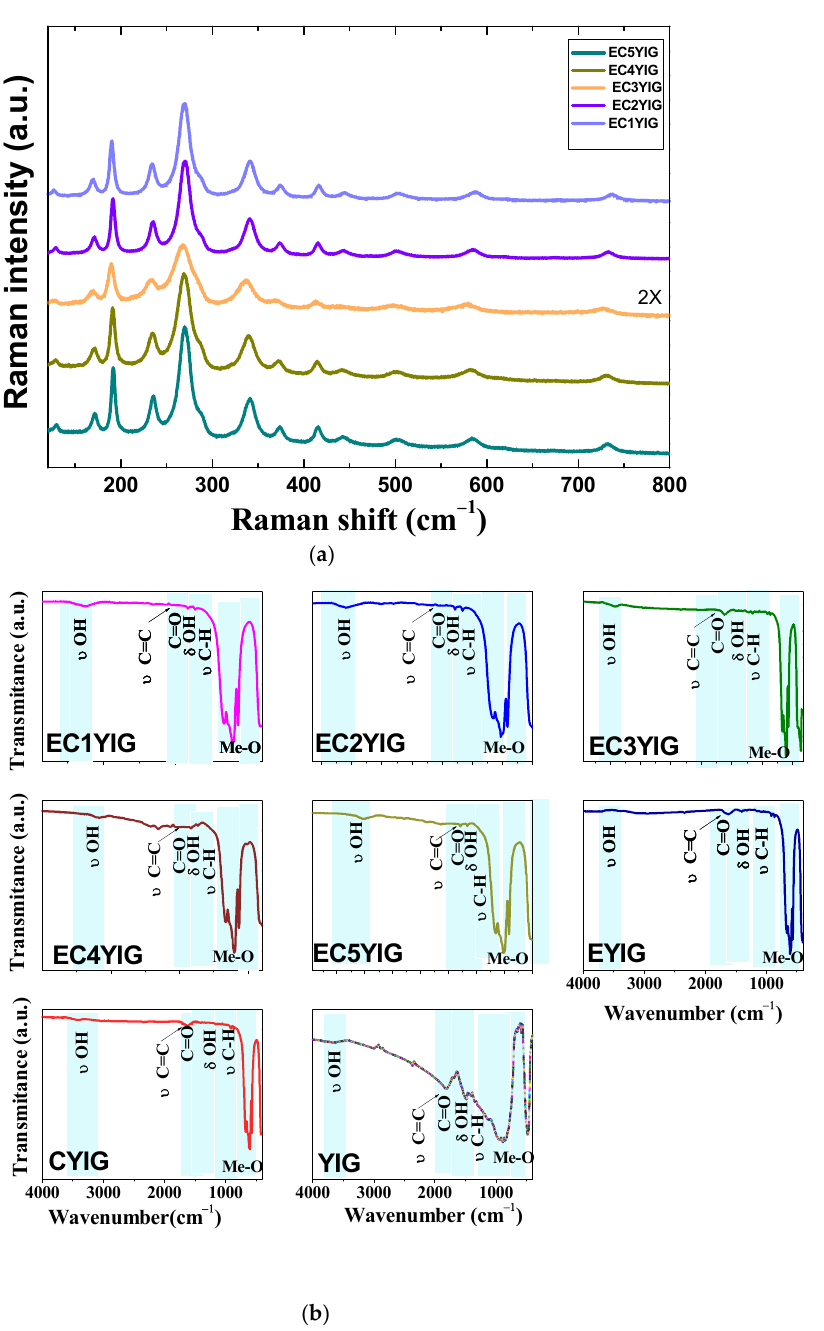
Figure 4. Structural features of spent yttrium iron garnet ferrites by ( a ) Raman and ( b ) FTIR measurements. For Raman spectrum of EC3YIG, the signal intensity was amplified by two times. Reaction conditions: EB to H 2 O 2 molar ratio of 1 using 1.3 mol of acetone as solvent, temperature of 50 °C and a catalyst mass of 50 mg within 360 min of reaction.